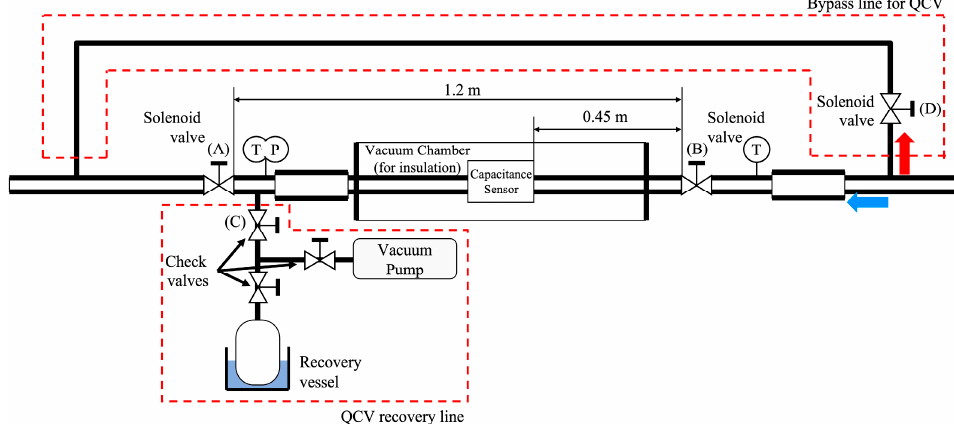
Figure 3. Detailed schematic of the test